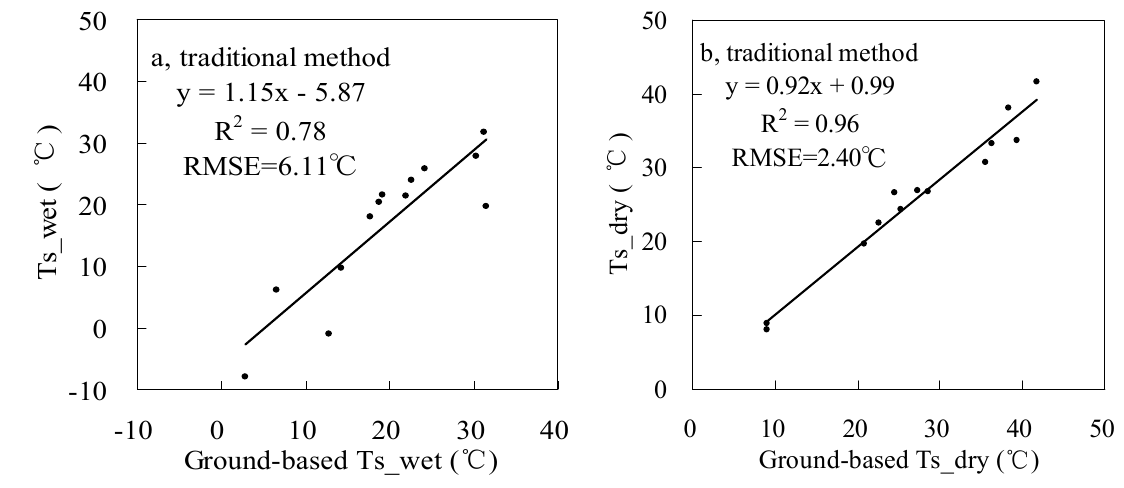
Figure 8. Comparisons of (a) Ts_wet and (b) Ts_dry between from the traditional method based on MODIS data and from ground data across the whole year of 2003.